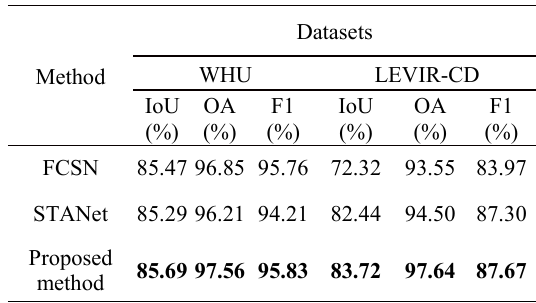
Table 2 . Comparison Accuracy using different methods. The bold values denote the best result.